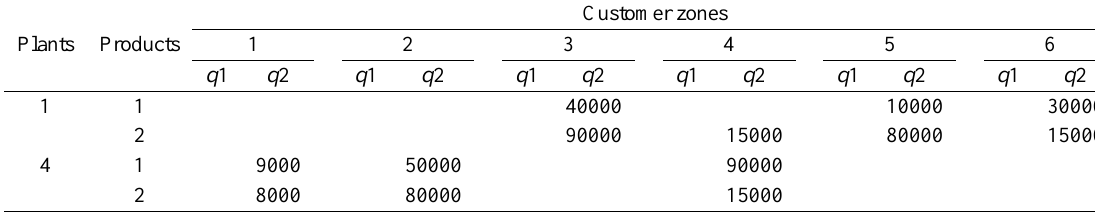
Table 9. Market share for each